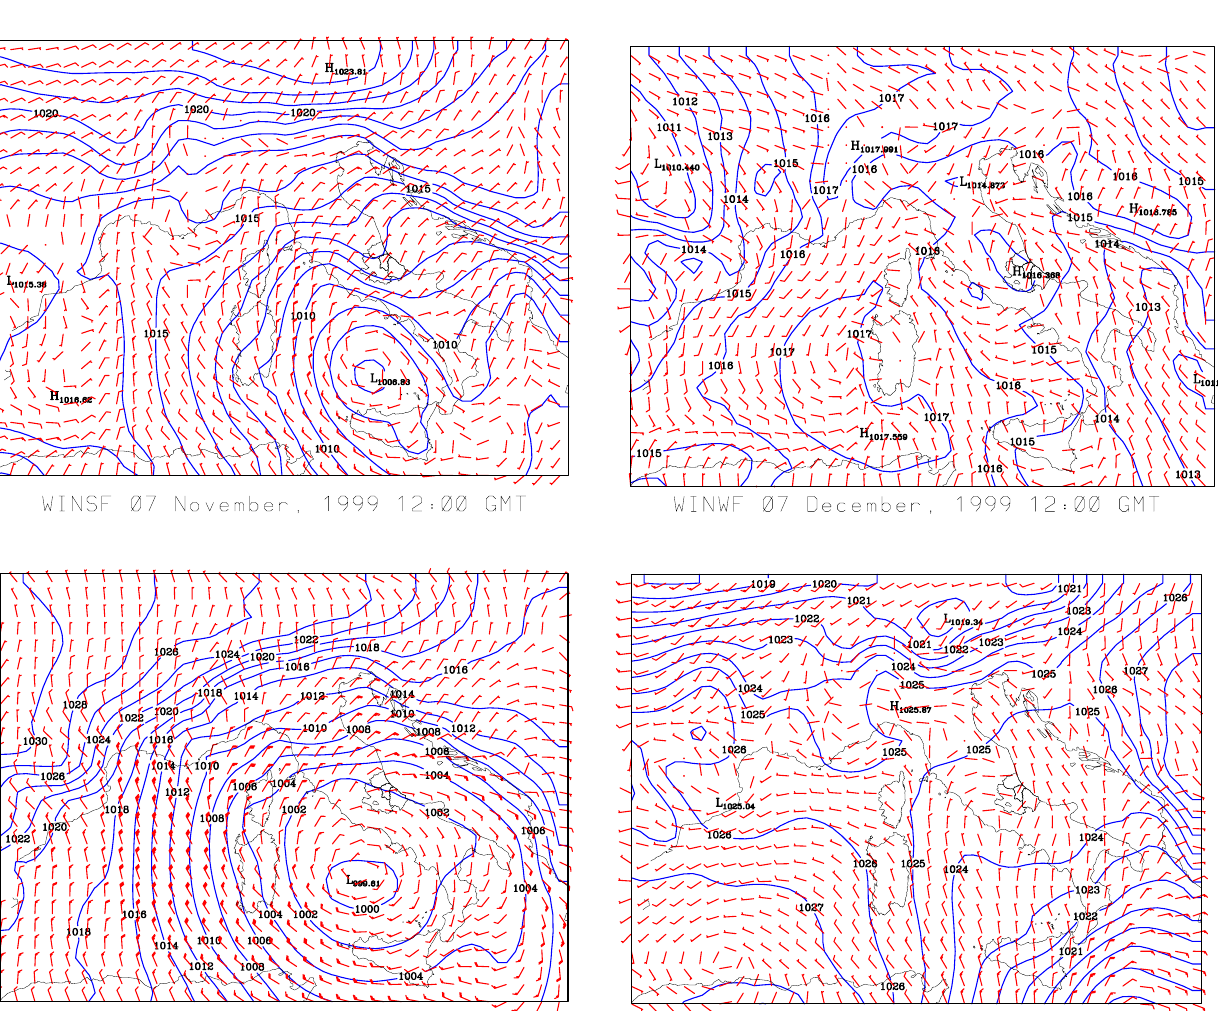
Fig. 3. Sea level pressure (mb) and wind speed (m/s) and direction at given times within the four simulated cases. (a) Case SUMSF, 24 July 1999, 12:00GMT; (b) Case SUMWF, 02 July 1999, 12:00GMT; (c) Case WINSF, 07 November 1999, 12:00GMT; (d) Case WINWF, 07 December 1999,